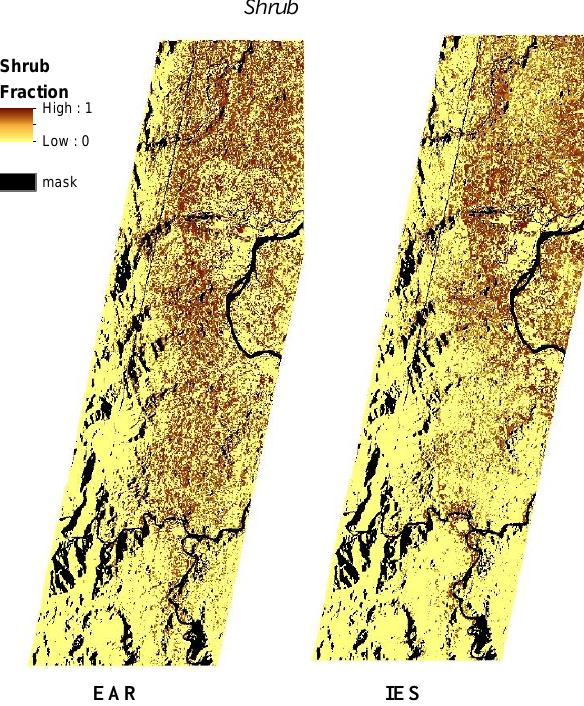
Figure 6. Fractional cover of shrubs based on MESMA unmixing using EAR and IES